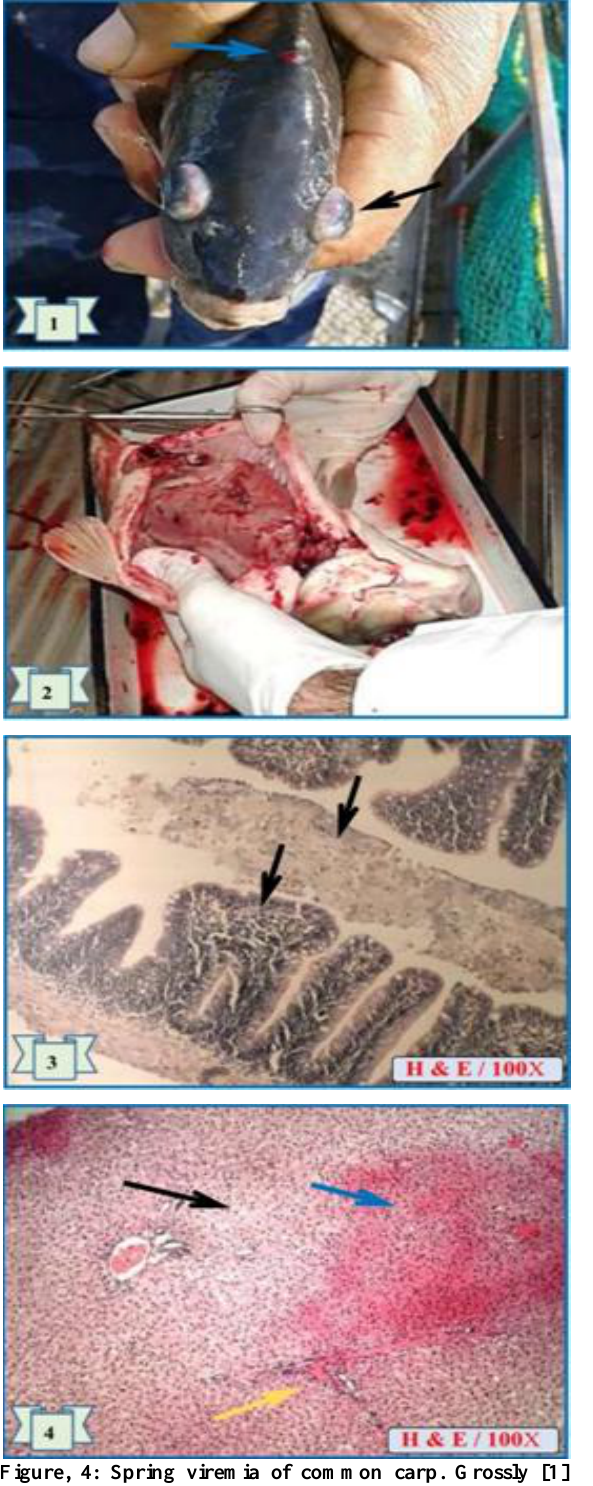
Figure, 5: Coccidiosis in common carp. Grossly [1] there is congestion and sever hemorrhage in intestines (arrow) at first stages of infection, which converted with time into flat nodular white lesions in intestinal lumen known as nodular coccidiosis [2] (arrow). Microscopically [3] there is different reproductive stages of coccidian parasite in the enterocytes (arrow), [4] these reproductive stages of coccidian parasite present in submucosal layer of intestines